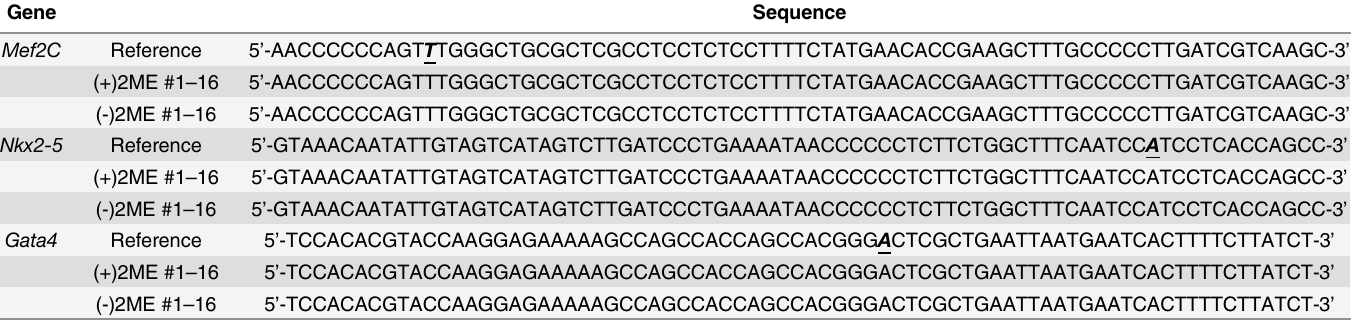
Table 3. Sequences surrounding the transcription start sites of Mef2C , Nkx2-5 , and Gata4 genes in R1 mouse ESCs subjected to oxidative stress. Gene